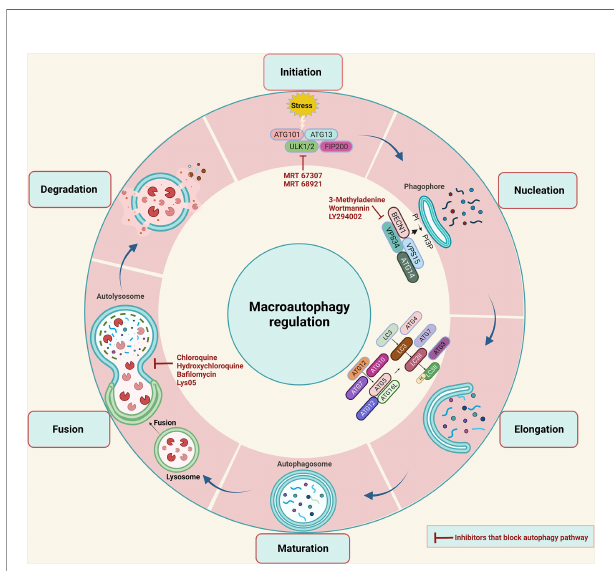
FIGURE 1 | A diagrammatic representation of the macroautophagy (also known as autophagy) process is shown. A phagophore forms in autophagy that sequester cytoplasmic material in a vesicle that later matures into an autophagosome, which then fuses with lysosomes to form an autolysosome, where the sequestered material is degraded. The autophagy process takes place in several steps such as Initiation, Nucleation, Elongation, Maturation, Fusion, and Degradation. The autophagy process can be blocked at various steps with the help of autophagy inhibitors listed in the red color.